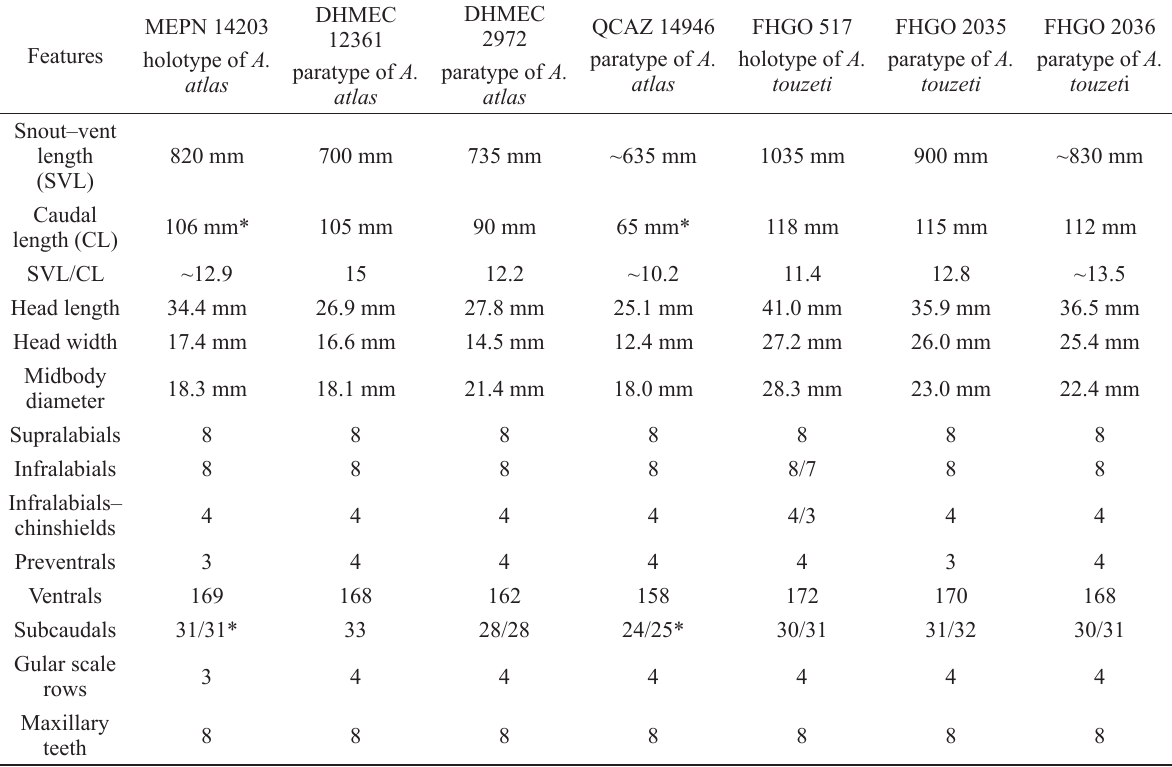
Meristic and morphometric variation for the type-series of Atractus atlas sp. nov. and of Atractus touzeti , both comprising by females only. The “~” represent the specimens for which the measurement was approximated according to their state of preservation or due to tail